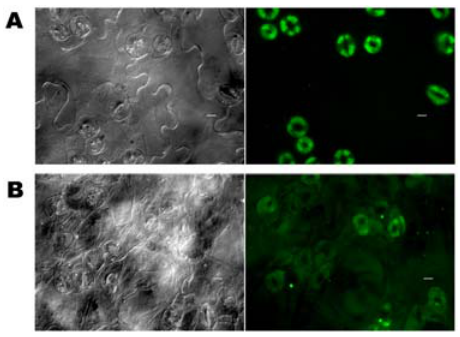
Figure 6. Characteristic changes of seedlings infected with P. aeruginosa PA14 or a lasR mutant. Seedlings were stained 3 dpi with membrane impermeable dye Sytox green (SG) after infection with ( A ) P. aeruginosa (PA14), ( B ) PA14:: lasR . Bright field image on left, sytox green fluorescence on the right. Scale bar indicates 10 m m.